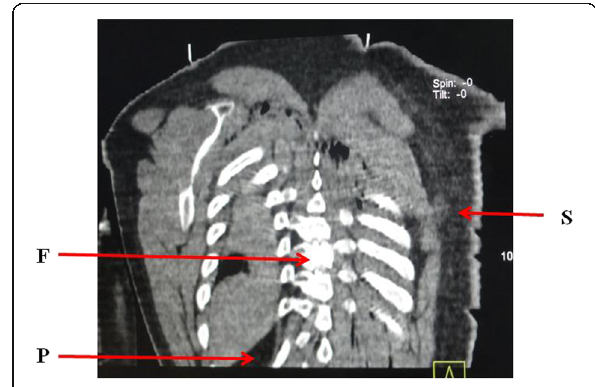
Fig. 6 PMCT coronal image showing pneumomediastinum (P), right side subcutaneous surgical emphysema (S), and fractures (F) in the 4th and 5th thoracic vertebrae